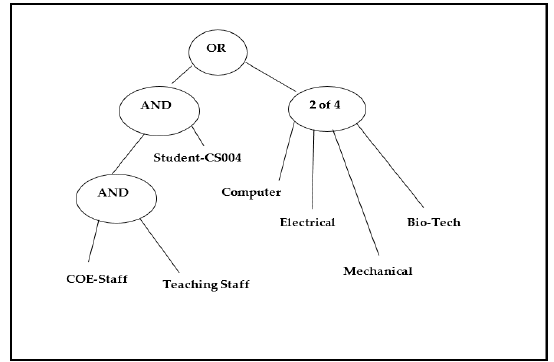
Figure 4. A sample access